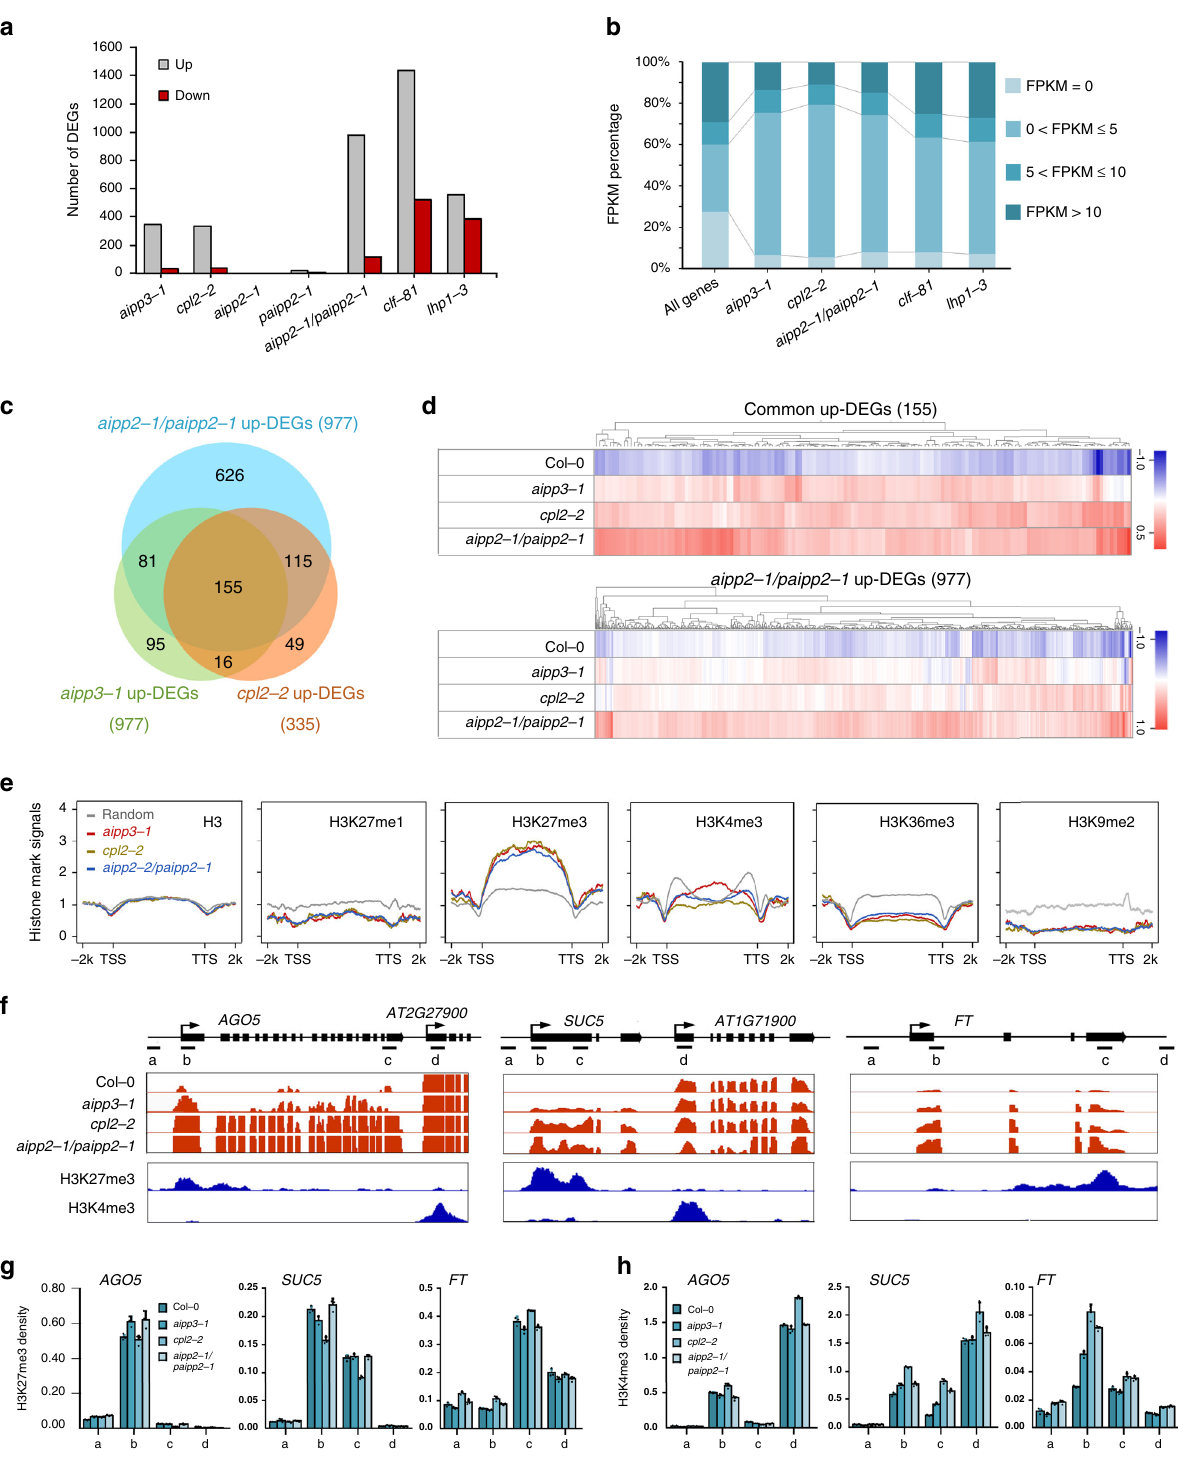
Fig. 4 BAH – PHD – CPL2 complex represses the expression of H3K27me3-enriched genes. a The numbers of up- and down-DEGs identi fi ed in the selected mutants. A twofold cutoff was used for the DEG criterion. b The BAH – PHD – CPL2 complex primarily represses low-expression genes. The gene expression levels of up-DEGs were classi fi ed into four groups according to their FPKM values in Col-0 mRNA-seq. All the annotated genes serve as controls. c A Venn diagram showing the overlap of up-DEGs between the selected mutants. d A heatmap showing the expression analysis in selected mutants. The genes in the upper and lower panels represent the common 155 up-DEGs and up-DEGs of aipp2-1paipp2-1 , respectively. e The distribution of different histone marks in the respective up-DEGs of selected mutants. TTS transcription termination site. f Snapshots showing the expression of the selected target genes. One representative replicate of mRNA-seq and histone ChIP-seq are shown. The adjacent genes with high H3K4me3/low H3K27me3 were also shown as parallel controls. g , h ChIP-qPCR showing the H3K27me3 ( g ) and H3K4me3 ( h ) density at the selected target genes. The ChIP signals were normalized to histone H3. The data are means ± S.D. of three technical repeats. One representative result of three biological replicates is shown. The lowercase letters represent the ChIP-qPCR examined regions as shown in f